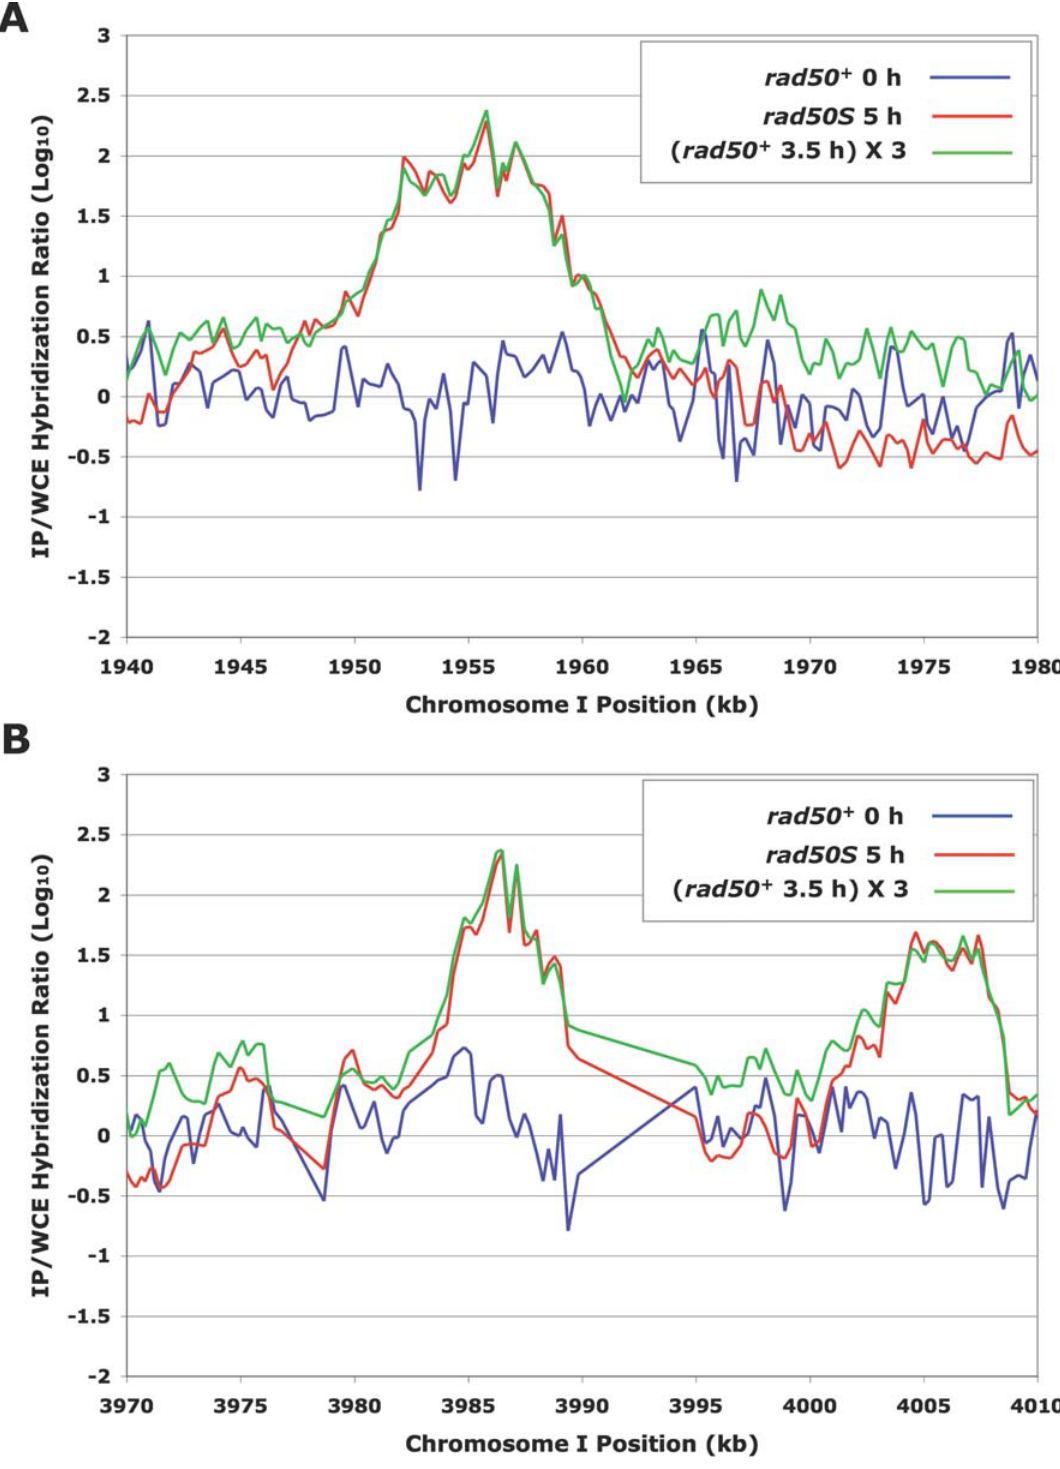
Figure 4. Enrichment Ratios at DSB Hotspots are Highly Correlated in rad50 + and rad50S Strains. Line graphs represent the median- normalized Rec12 IP/WCE ratios at hotspot sites from (A) Not I D and (B) Not I K restriction fragments using Dataset S2. At probes showing IP enrichment (peaks), IP/WCE ratios are closely correlated between the rad50 + (GP6232) and rad50S (GP6203) data, with ratios , 3-fold higher in the rad50S data.